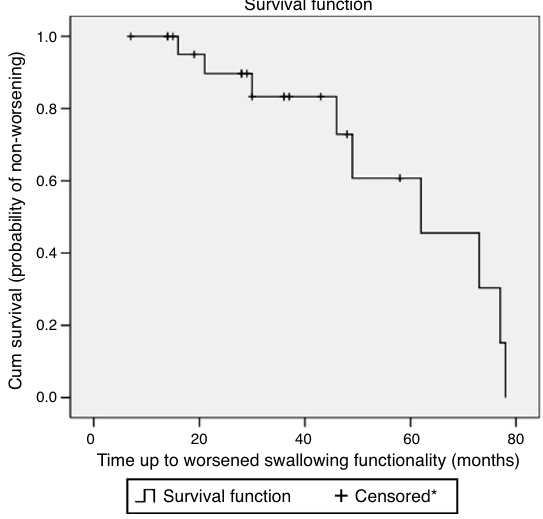
Survival plot considering worsened swallowing according to Functional Oral Intake Scale (FOIS) levels in Parkinson’s disease patients followed at a dysphagia outpatient between 2006 and 2011 ( n = 24). *Censored observation shows patients lost in follow-up or patients without worsened swal- lowing functionality during the observation period.